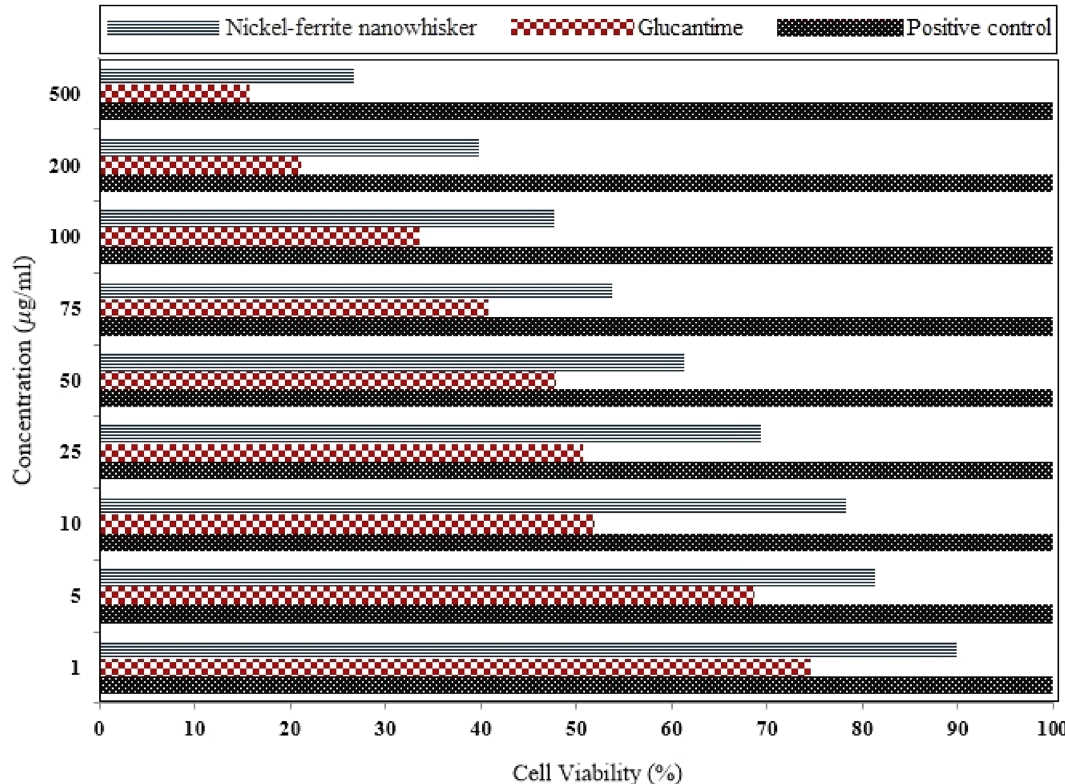
Figure 4. Survival percentage of L. major after 48 h of the exposure to different concentrations of nickel-ferrite